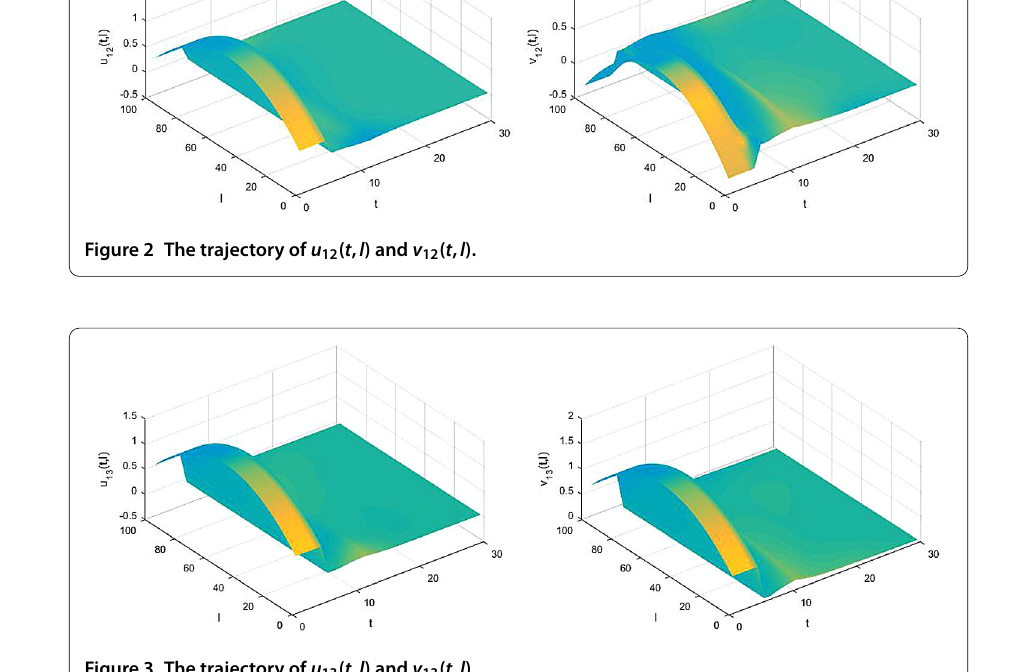
Figure 3 The trajectory of u 13 ( t , l ) and v 13 ( t , l ).